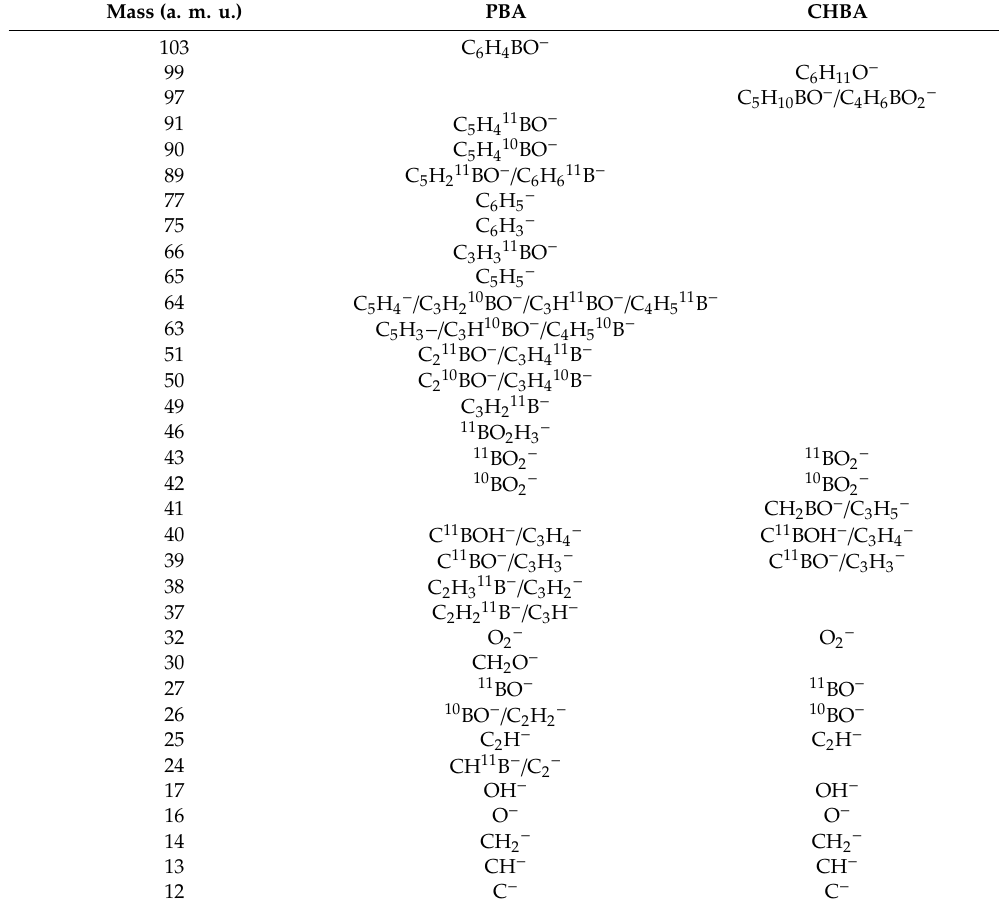
Table 1. Assignment of negative ions formed in neutral potassium collisions with phenyl boronic acid (PBA) and cyclohexyl boronic acid (CHBA). Mass (a. m. u.)